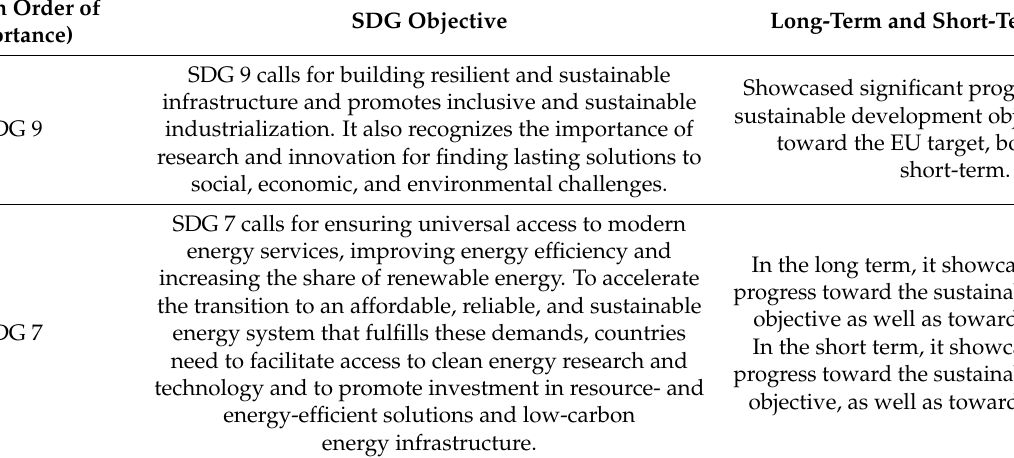
Table 3. KT synergies in energy sector analyzed in connection to the